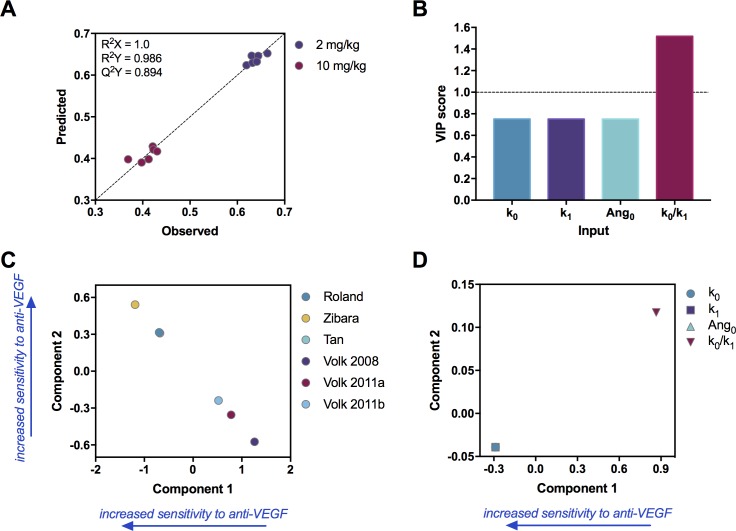
Results from multivariate analysis.PLSR analysis quantifies how the tumor growth parameters influence the response to treatment (RTV). A, PLSR model to predict RTV for two dosage levels of the anti-VEGF. The optimal PLSR model includes two components. Decreasing in component 1 or increasing in component 2 corresponds to higher efficacy of the anti-VEGF treatment. B, VIP scores for the model inputs; a score greater than one indicate variables that are important for predicting the RTV. C, Scores of the model output, revealing how tumors from each dataset compare in their responsiveness to treatment. D, Loadings of the model inputs, indicating how the model inputs (fitted parameters) correspond to sensitivity to anti-VEGF treatment.